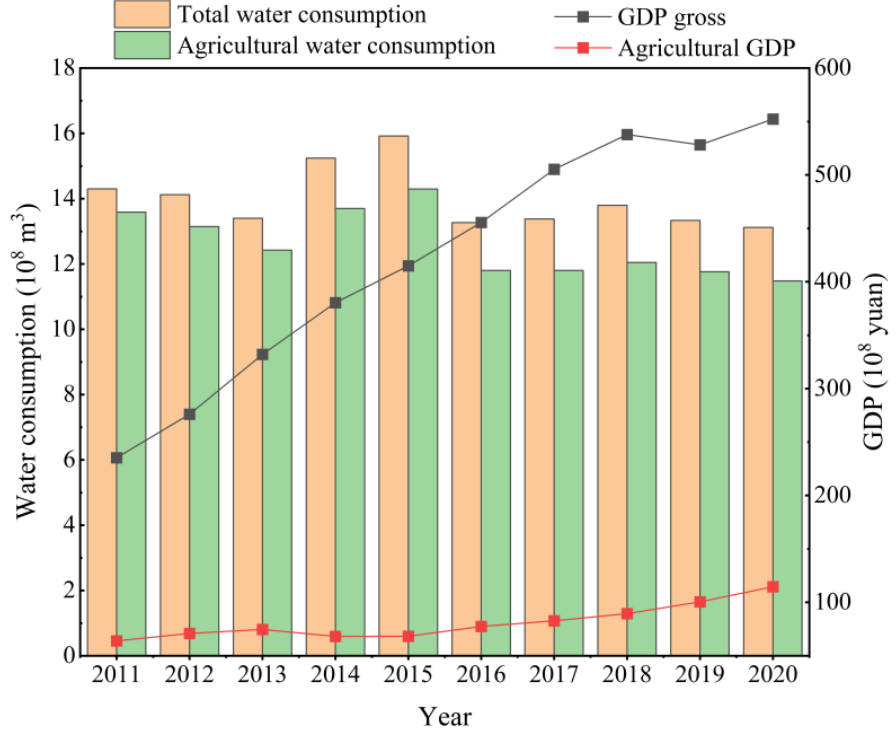
Figure 6. Comparison of agricultural water use and production with total water use and total production value of Shihezi from 2011 to 2020.